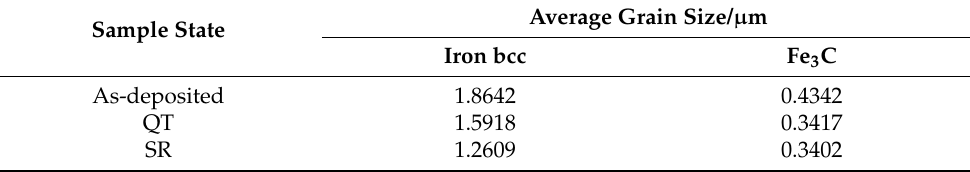
Table 4. Grain sizes in different